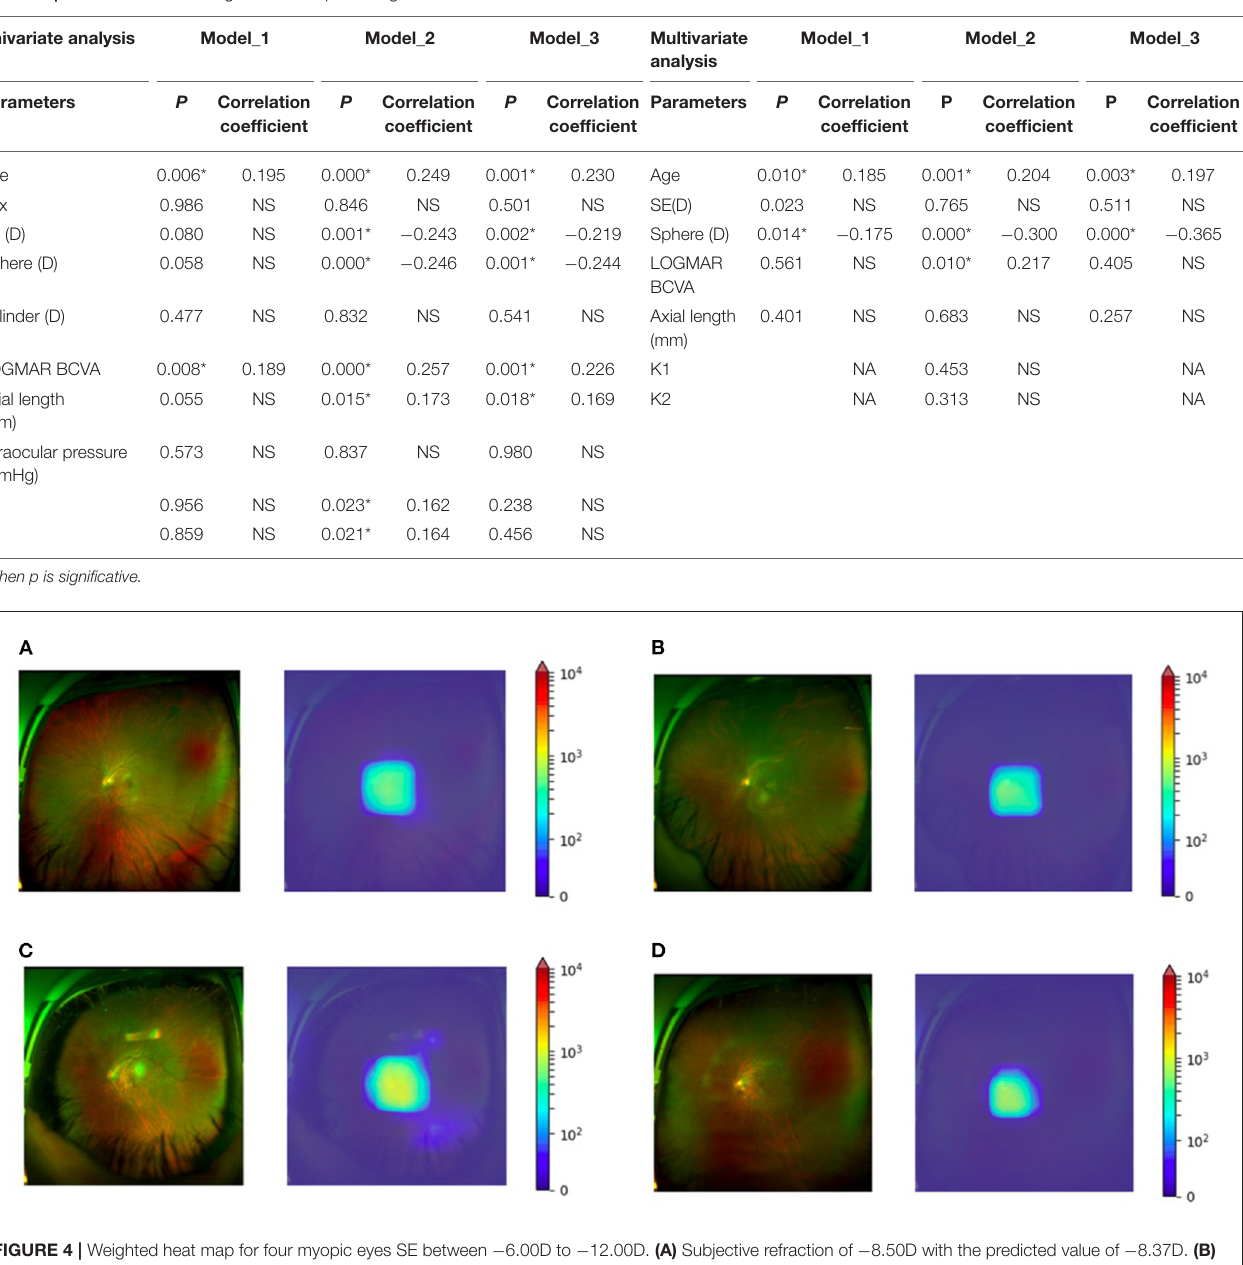
TABLE 1 | Parameters influencing MAE in deep learning models.